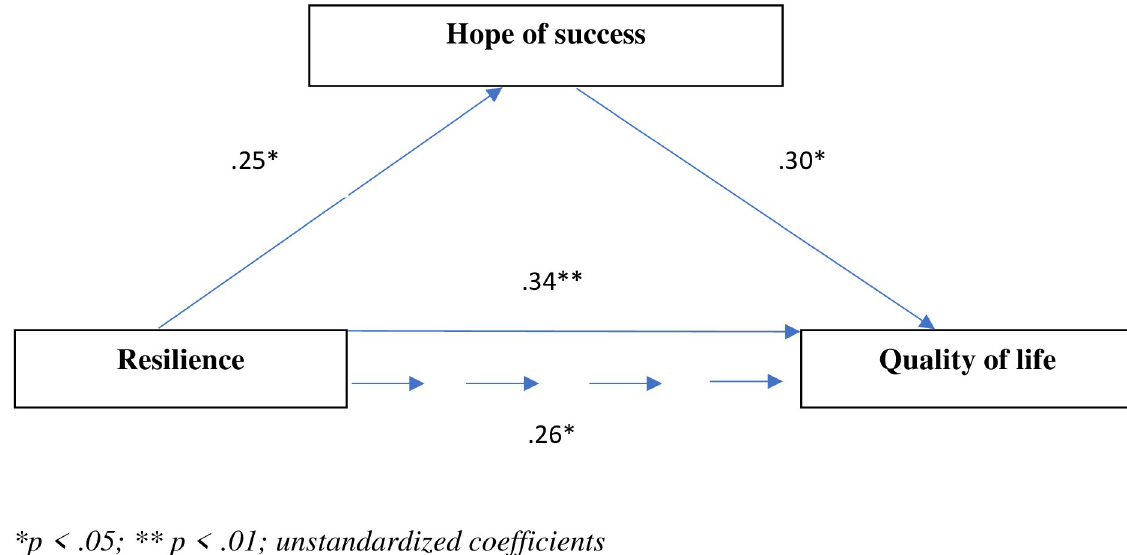
Fig 3. Model of relationships between resilience, hope of success, and quality of life.